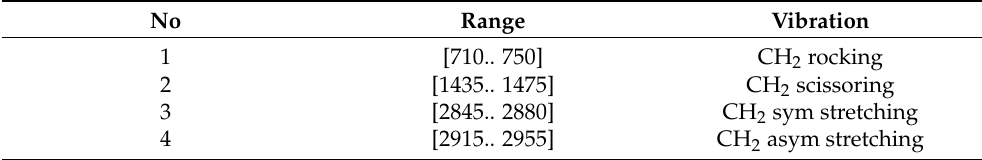
Table 6. Peak position and vibration type of the CH 2